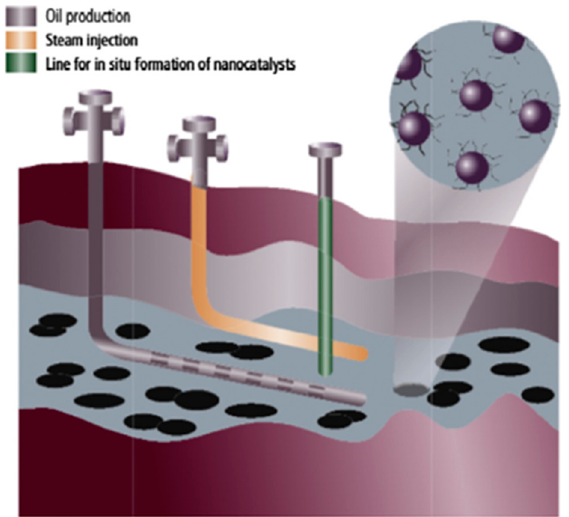
Figure 15. The schematic diagram of the nano-assisted steam-assisted gravity drainage (SAGD)